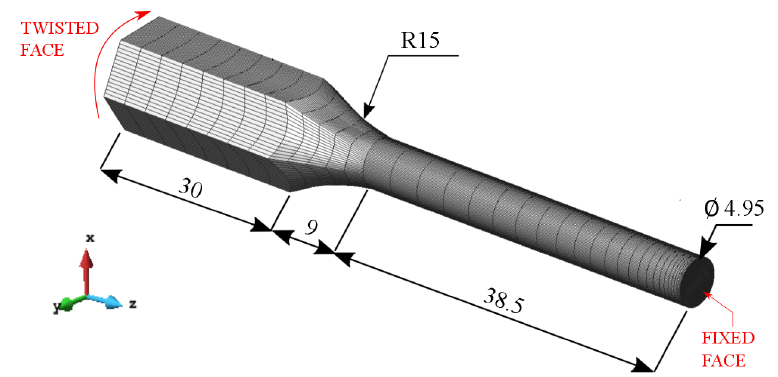
Figure 8. Torsion test: finite element mesh and boundary conditions (dimensions in